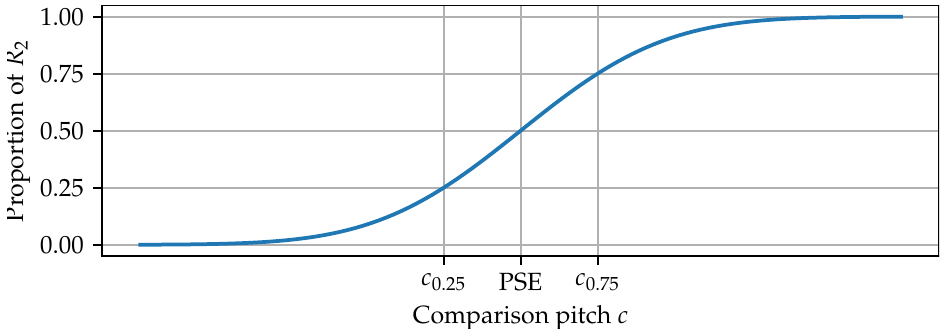
Figure 2. Psychometric function with quartiles c 0.25 , PSE and c 0.75